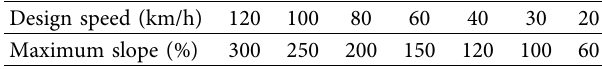
Table 7: Current minimum length of highway slopes.